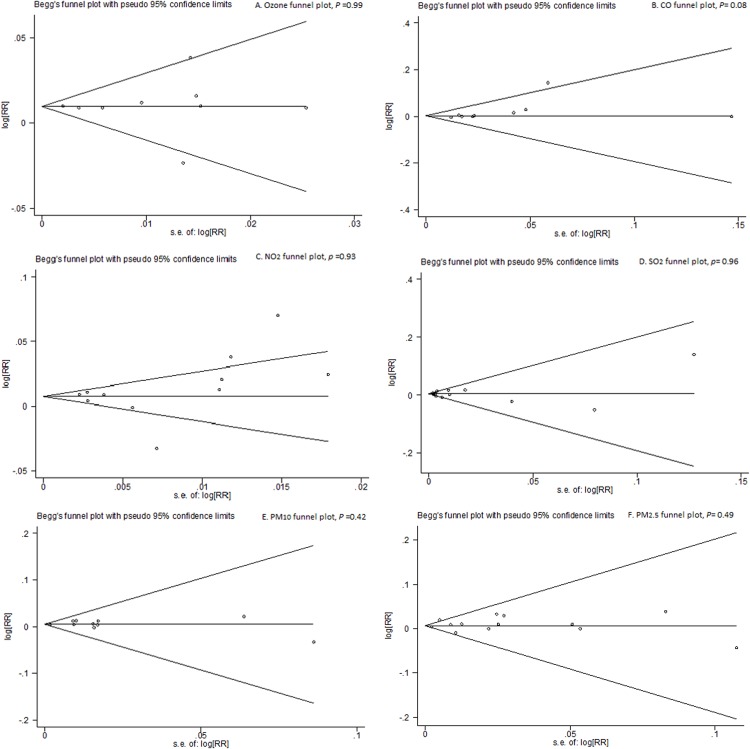
Funnel plots for relative risks of ERVs/hospital admissions for asthma in relation to the six air pollutants in lag pattern sensitivity analyses.A) Funnel plot for ozone; B) Funnel plot for CO; C) Funnel plot for NO2; D) Funnel plot for SO2; E) Funnel plot for PM10; F) Funnel plot for PM2.5.